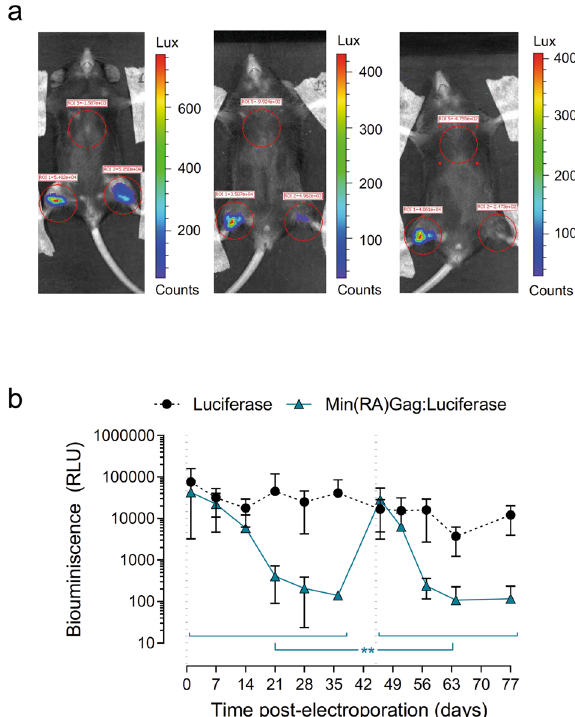
Fig. 5 In vivo bioluminescence kinetics of DNA co-electroporation in mice. C57BL/6JOlaHsd mice ( n = 5) were electroporated with 20 µg of DNA of both a 1:1 mix of pVAX1:pVAX1- Fluc at the right limb (black rounds) at day 0 and a 1:1 mix of pVAX1- Fluc :pVAX1- min(RA)gag at the left limb (blue triangles) at day 0 and 45. a Representative bioluminescence images of co-electroporated mice at 48 h (left), 7 days (middle) and 14 days (right) post- electroporation. b Bioluminescence follow-up of electroporated mice. Data represented as mean ± SD. Signi fi cant differences between the fi rst and the second electroporation (days 0 – 35 and 46 – 77, respectively) at the left limb (pVAX1- Fluc :pVAX1- min(RA)gag ) were assessed comparing nested mixed effect models and considering time as a categorical factor ( **p = 0.0012; likelihood ratio